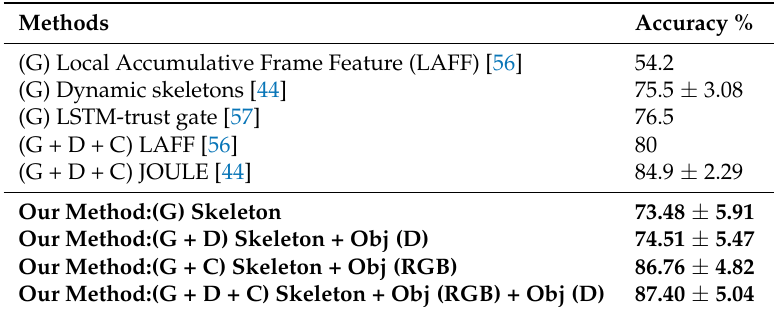
Figure 5. SYSU 3D Human-Object Interaction dataset confusion matrix based on skeleton, depth, and 图 5 color data (G + D + C). Table 5. Comparison on the SYSU 3D dataset. (D) depth; (C) color (or RGB); (G) geometry or